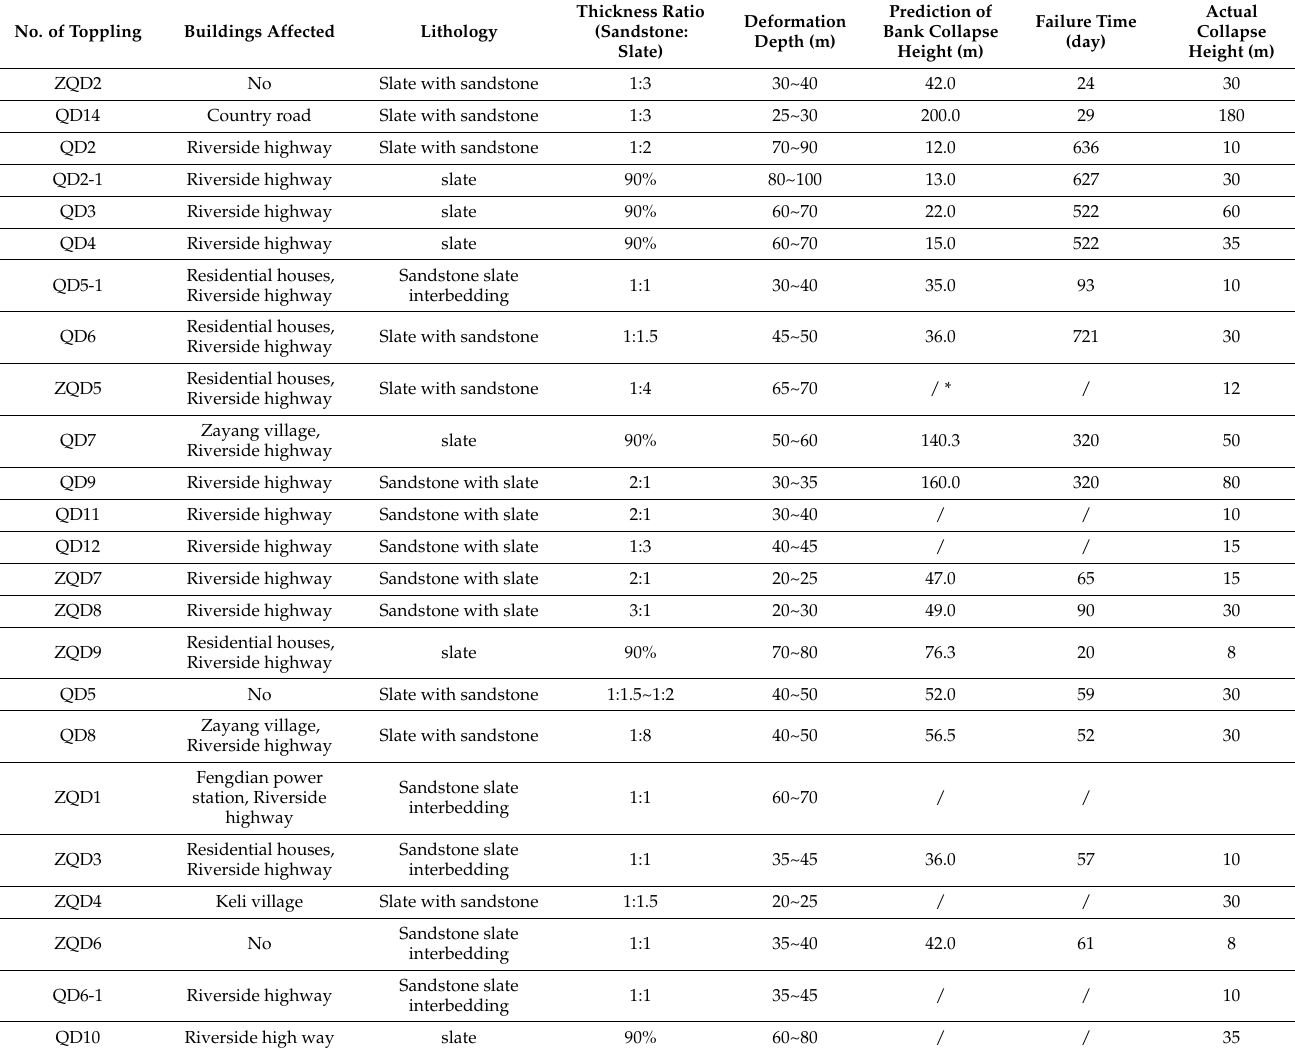
Table 6. Prediction results for the final failure range of the toppling deformed bank slope under the condition of 1408-m water